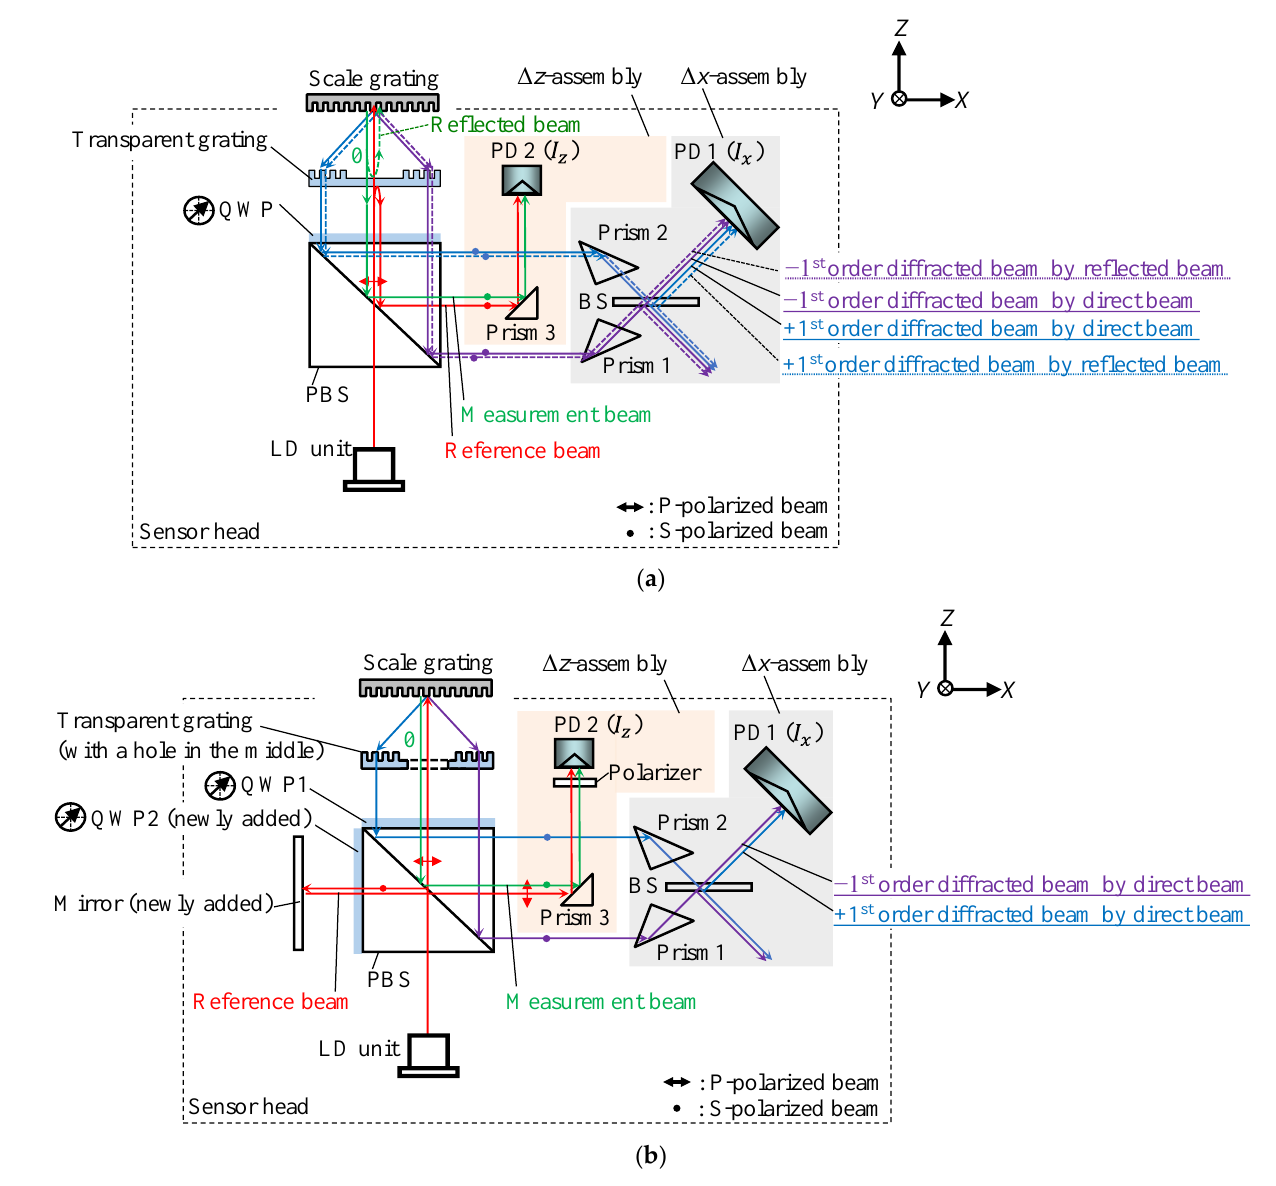
Figure 1. Optical configurations of the surface encoder: ( a ) The optical configuration of the conven- tional surface encoder with an expanded Z-directional measuring range; ( b ) The optical configuration of the newly proposed surface encoder.